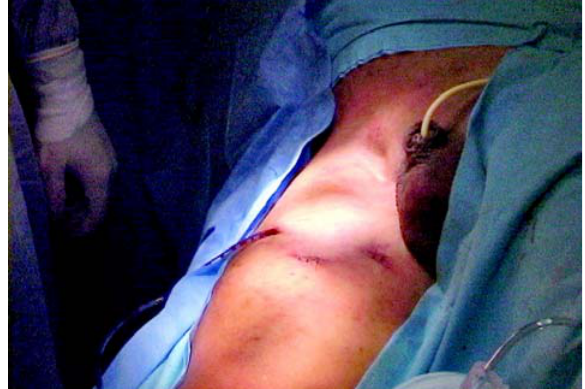
Figure 7 – Final aspect of the incisions and vacuum